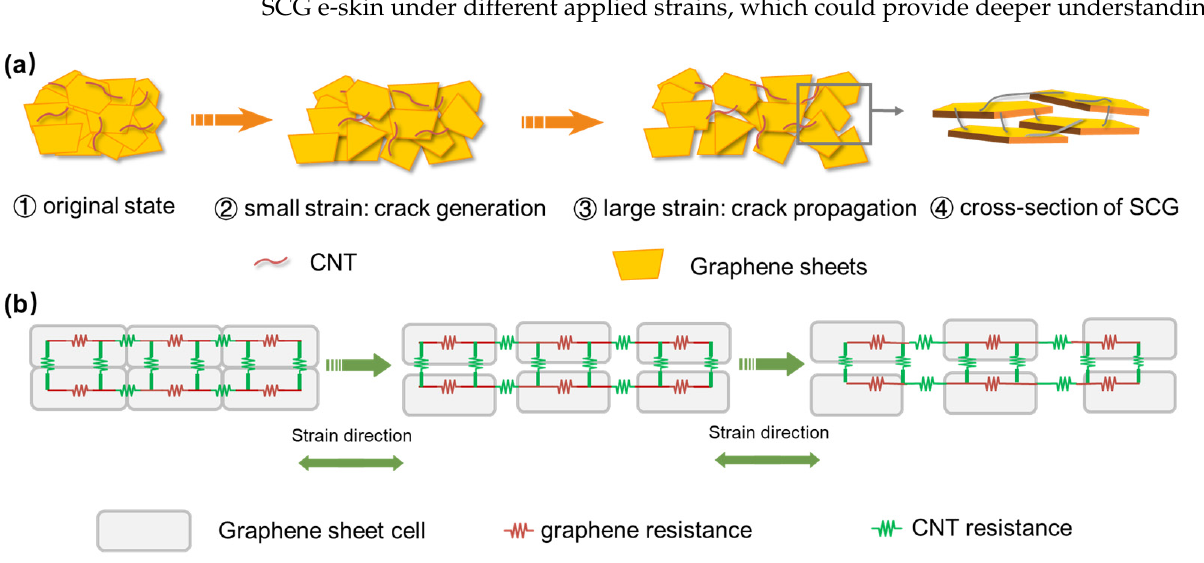
Figure 3. The relative resistance variation mechanism of the Graphene/CNT e-skin. ( a ) Layered stacked graphene flacks with CNTs crosslinked e-skin on original state, and generation and propagation of the crack under small and large strains. The arrow indicates the schematic diagram of the cross-section. ( b ) The resistance model of the SCG e-skin under different strains.